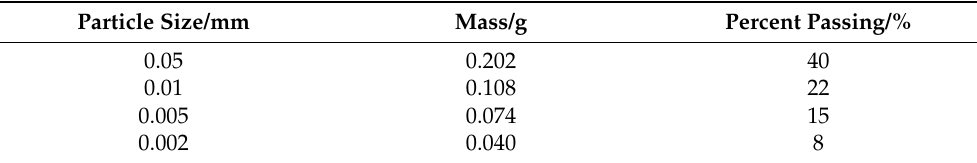
Table 3. The results of particle size analysis of fine-grained